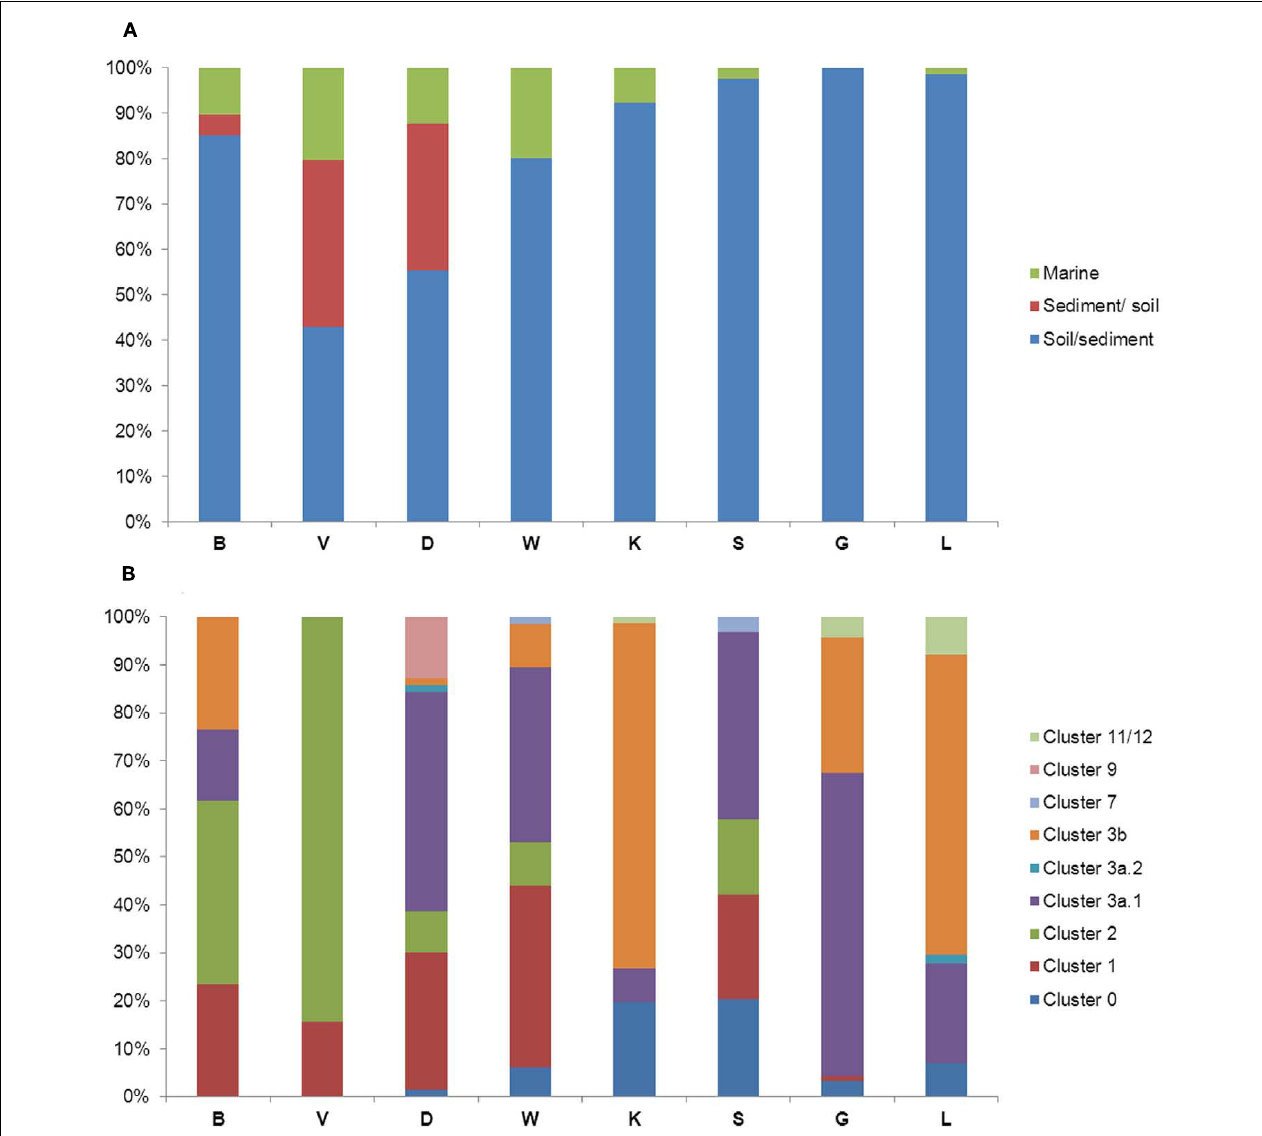
FIGURE 4 | Diversity of archaeal (A) and bacterial (B) amo A sequences retrieved in this study from the eight soils. Archaeal and bacterial amo A clusters were classified according to Nicol et al. (2008) and Zhang et al. (2009), respectively. See Figure 1 for soil names.